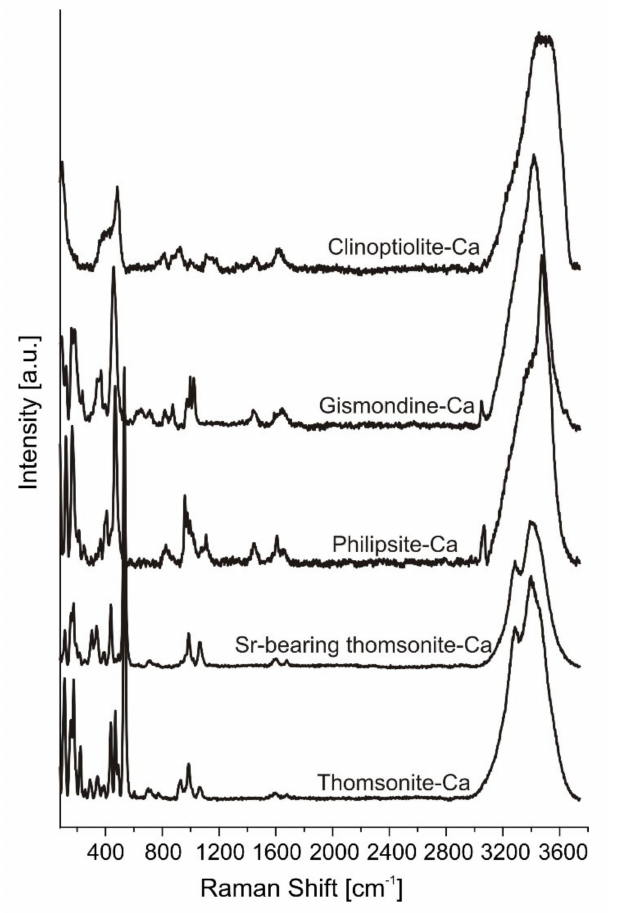
Figure 6. Raman spectra of zeolites under